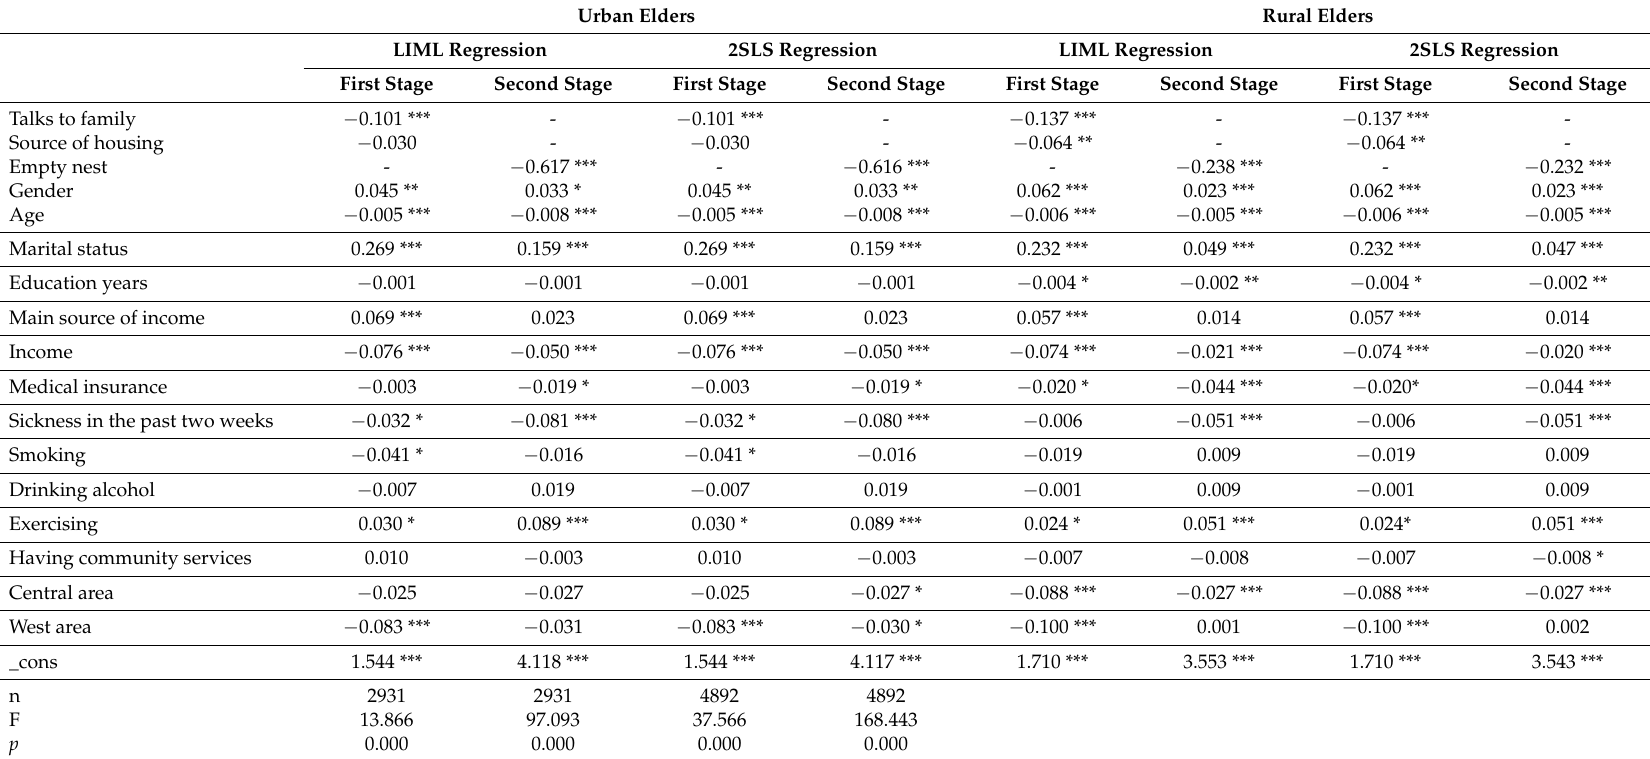
Table 3. Effects of an empty nest on urban and rural elders’ ADL. Urban Elders Rural Elders LIML Regression 2SLS Regression LIML Regression 2SLS